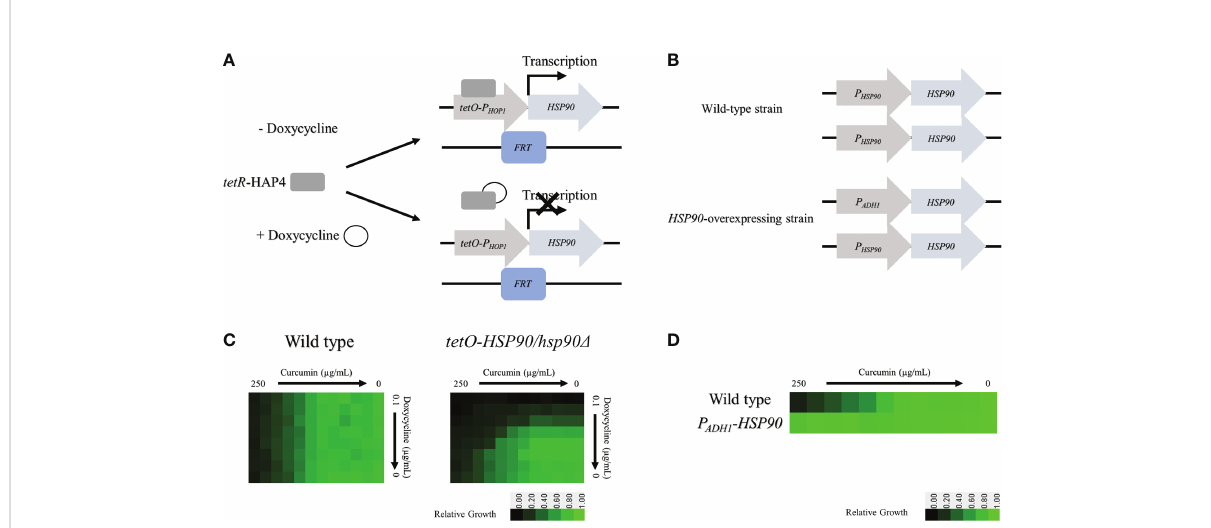
FIGURE 3 Depletion of HSP90 increases the sensitivity of cells to curcumin. (A) Diagram showing control of the tetR-regulated tetO-HSP90 fusion gene. In the absence of Dox, tetR can bind to and induce HSP90 expression. (B) Checkboard assays for curcumin in combination with Dox tested against C albicans in YPD medium. The optical density of cells at 530 nm (OD 530 ) is colored between dark green (no yeast growth) and light green (maximum growth) relative to the control. Data are quantitatively displayed with color using Java TreeView 1.2.0. (C) Diagram showing the HSP90 promoter replaced with the ADH1 promoter. (D) Diagram of the microbroth dilution assay for curcumin against the overexpression mutant P ADH1 -HSP90 in YPD medium. The cells were treated with curcumin at 37°C for 24